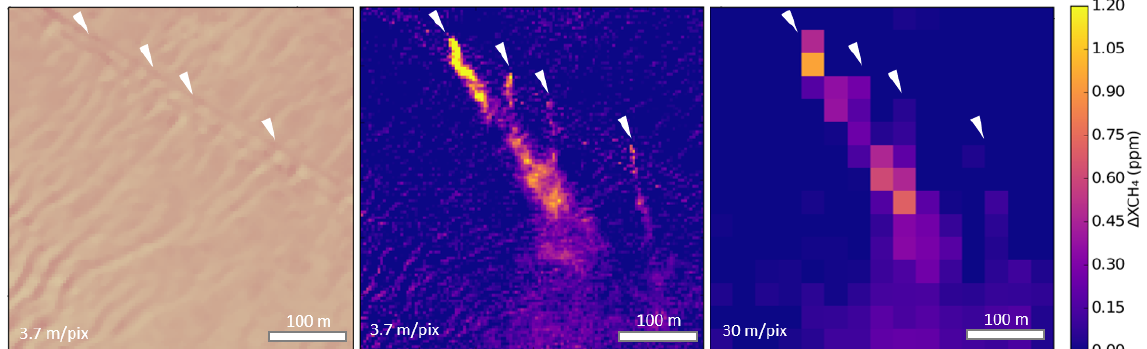
Figure 14. Detailed example for Turkmenistan North; Goturdepe O&G field on 29 March 2021 where four plumes are seen coming out of a pipeline around 39.485 ◦ N, 53.663 ◦ E (zoom of Fig. 13b). Left panel uses Band 1 of the © WV-3 SWIR images as a background.